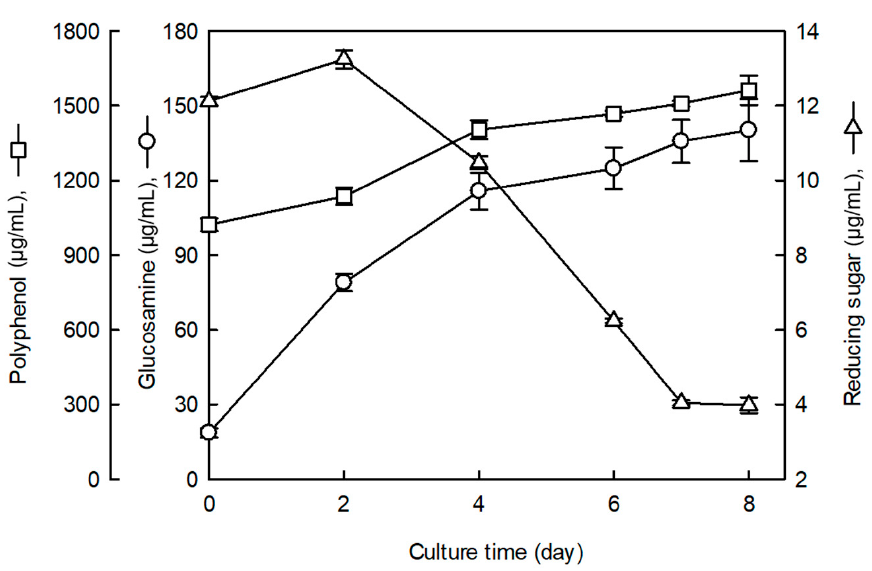
Figure 1. Changes in reducing sugar, polyphenol, and glucosamine contents during the fermentation of spent coffee grounds (SCG) by C. sinensis . Values are the means ± SD ( n = 3).